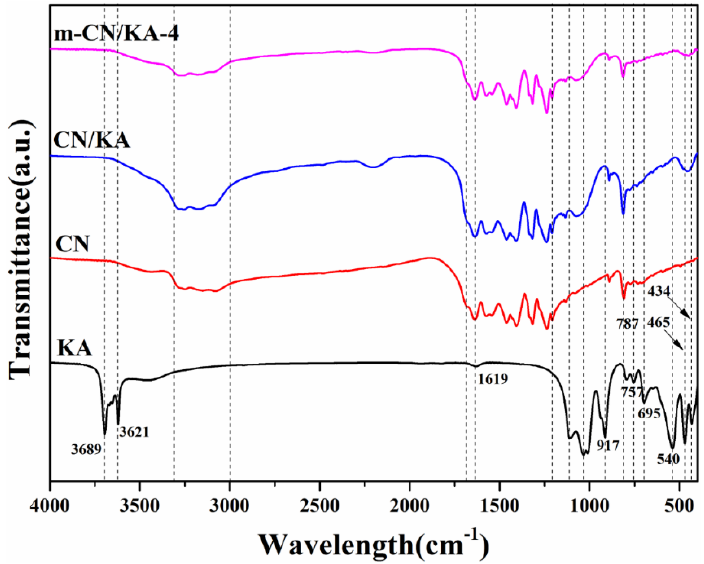
Figure 5. FT-IR spectra of CN, KA, CN/KA composite, and m-CN/KA-4 composite.